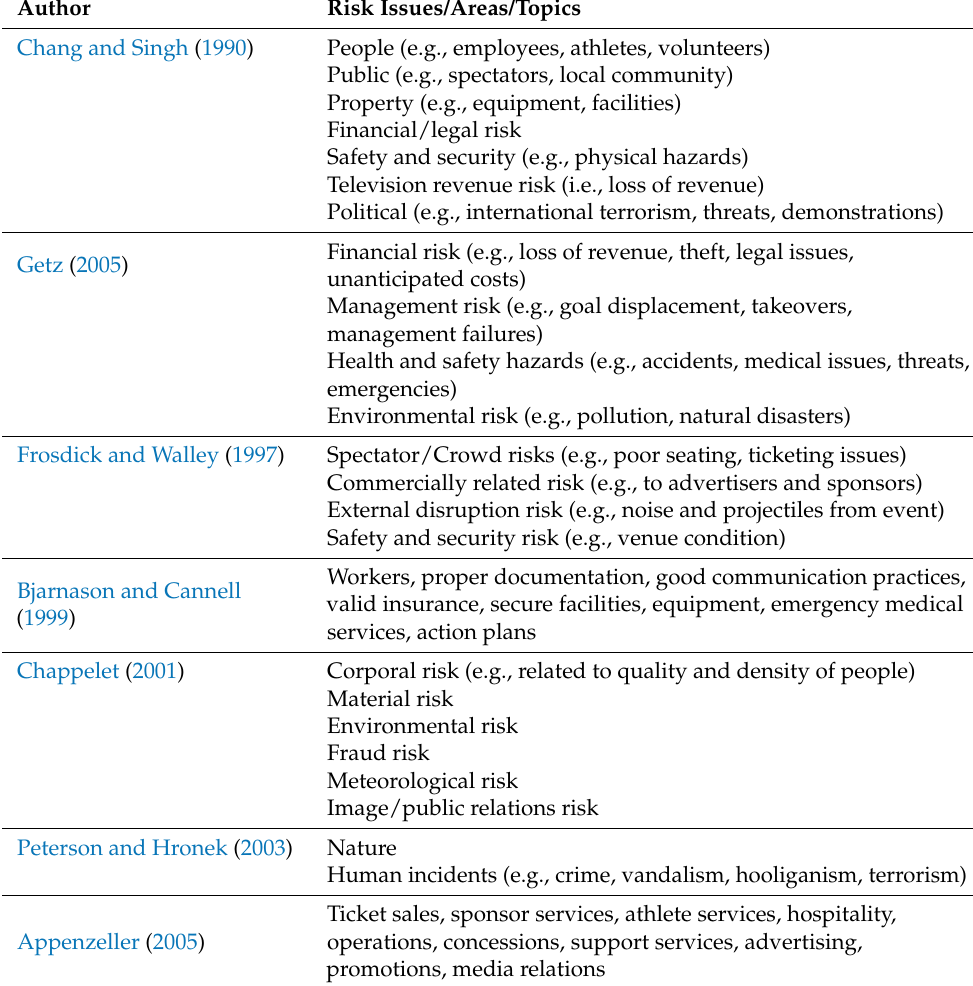
Table 1. Elaborated summary of previous event-related risk and risk-management issues highlighted in the scholarly literature (Leopkey and Parent